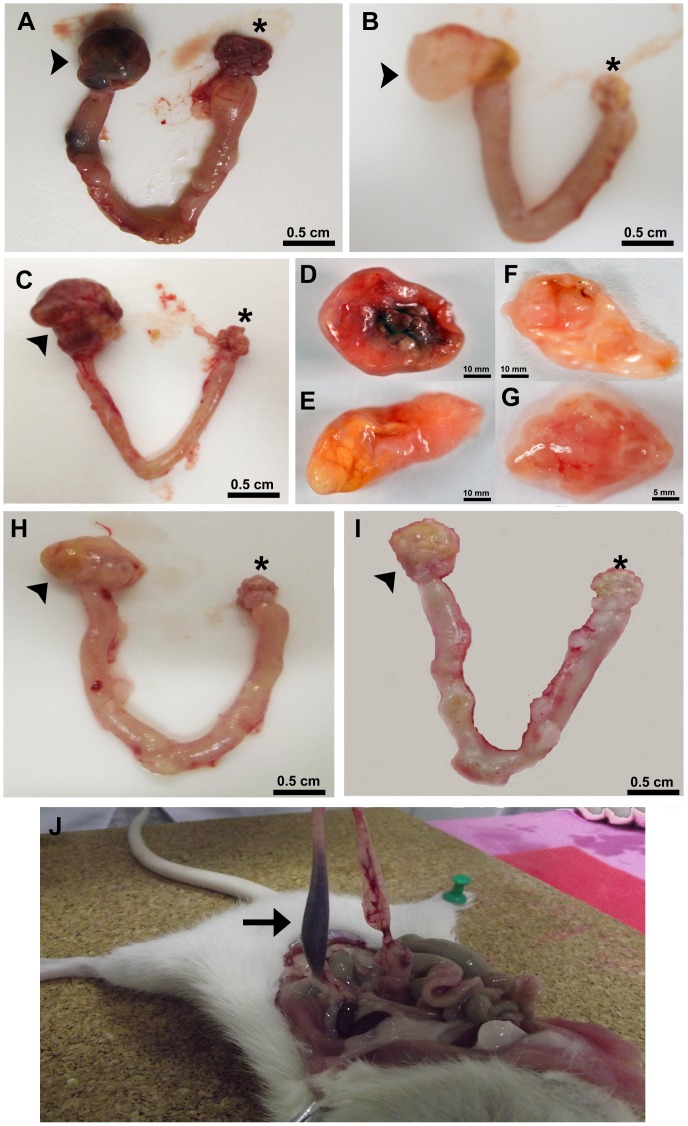
Photographs of the most common ovarian tumors 180 days post-DMBA induction.(A and C) The left ovary (arrowhead) of an animal from the C+EtOH group showing a solid mass with scattered necrosis. (B) The left ovary (arrowhead) of an animal from Group C, displaying a larger sized cyst containing serous secretions. High magnification of ovarian neoplasms in the C+EtOH (D), C+M (E), and C+EtOH+M groups (F), and a sham-operated right ovary (G). The left ovaries (arrowhead) of animals from the C+EtOH+M (H) and C+M (I) groups. (J) Left uterine horn (black arrow), displaying internal blood stasis. (*) indicates the intact right ovary (which was only treated with the vehicle). Proliferating cancer cells increased the ovarian masses to diameters >4-fold in size (left ovaries).